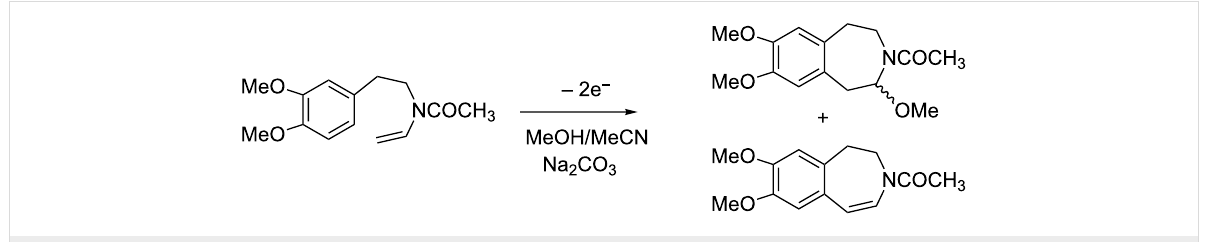
Scheme 3: Intramolecular cyclization via anodic oxidation of an eneamide.